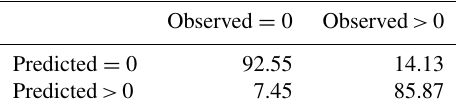
Table 1. Accuracy of the wet/dry day estimates: percent of observed dry ( P (precipitation) = 0) and wet ( P > 0) days, and percent of predicted dry (RV = 0) and wet (RV > 0) days on observed dry and wet